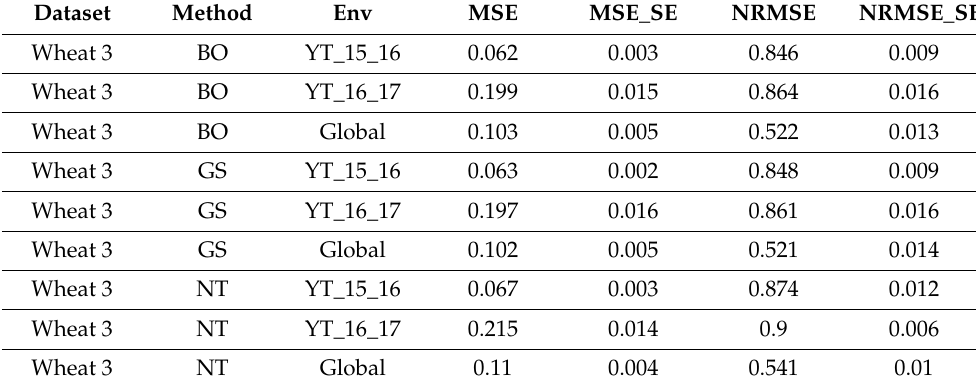
Table A5. Prediction performance for every environment and across environments (Global) of the dataset 3 in terms of their mean squared error (MSE), normalized root mean square error (NRMSE) under three methods of tuning (BO, GrS, and NT). MSE_SE and NRMSE_SE denotes the standard errors (SE) under MSE and NRMSE.